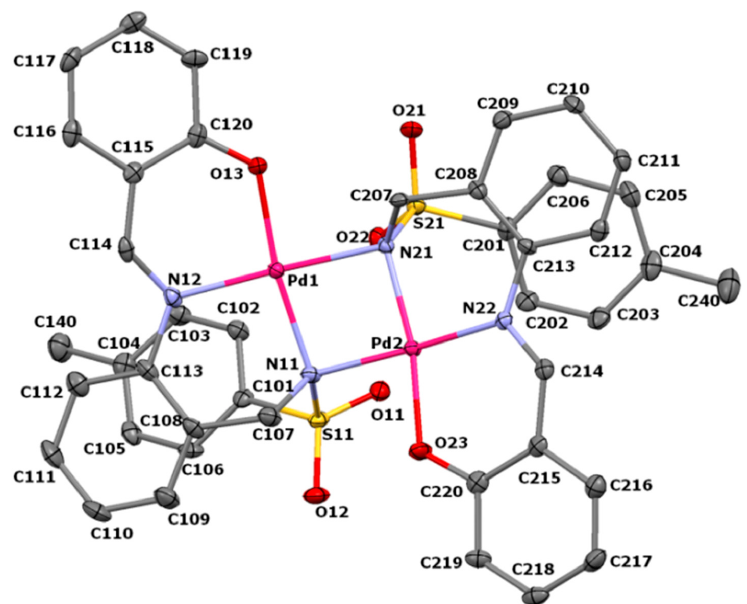
Figure 3. Ellipsoid view (50% of probability) of the molecular structure of Pd 2 (SB) 2 ·Me 2 CO. H atoms and the solvated acetone molecule have been omitted for clarity.